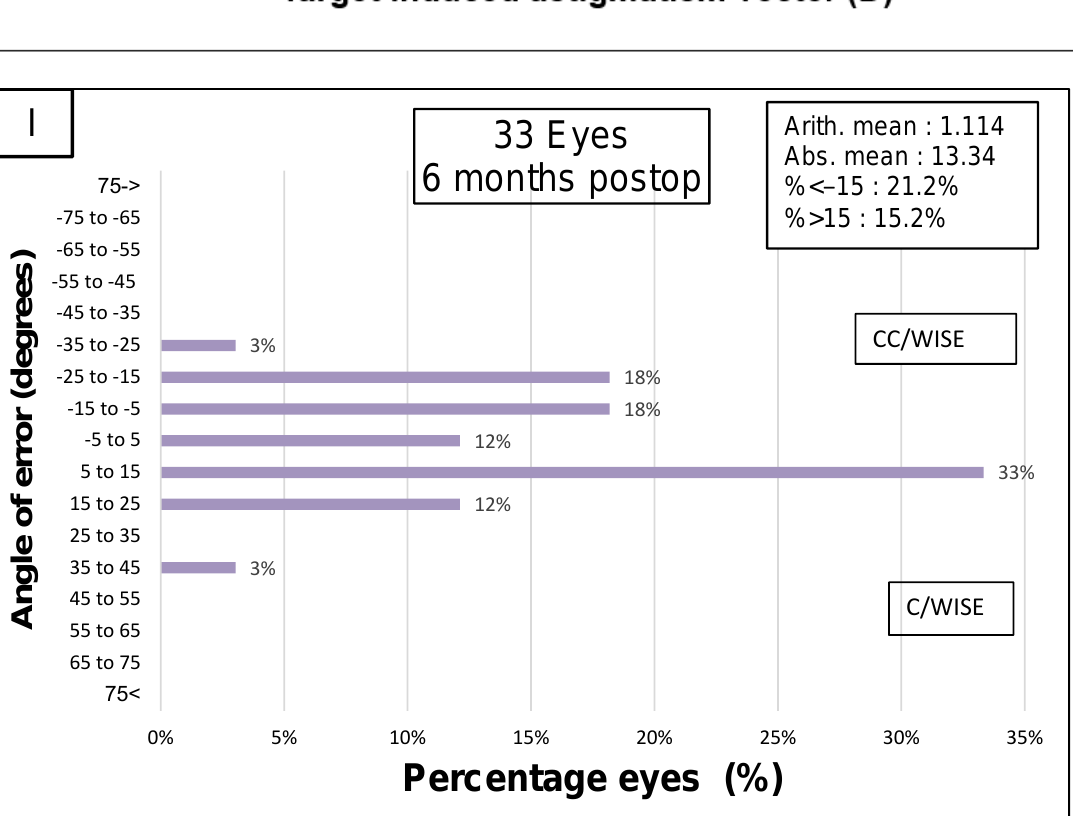
Figure 3. Standard graphs for corneal refractive surgery. ( A ): At 6 months after surgery, 52% of patients had a UDVA of 20/40 or better. ( B ): Difference between UDVA and CDVA 6 months